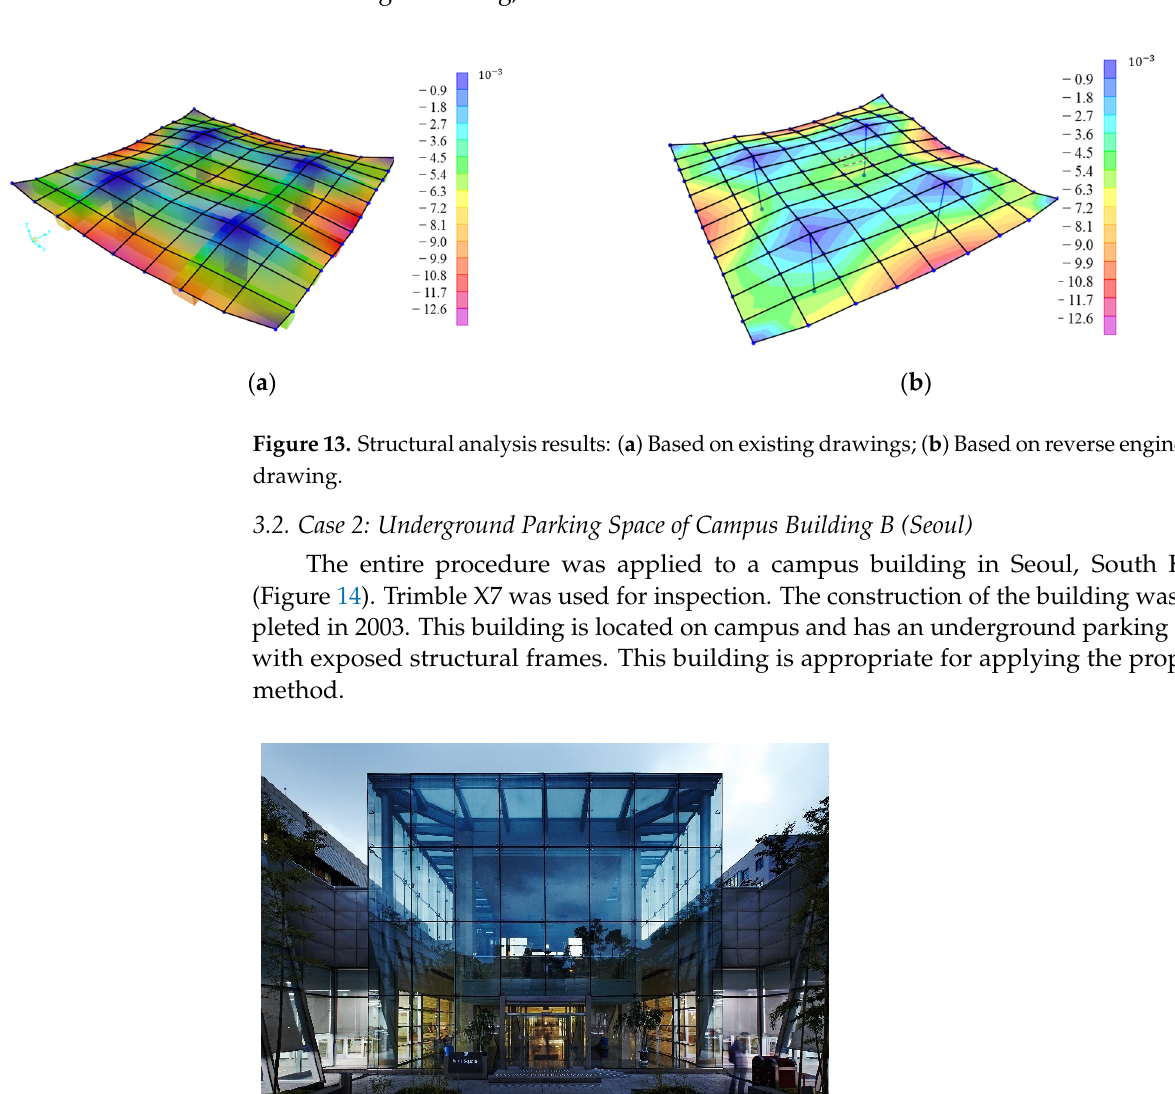
Figure 15. Scanning path of Case 2 (Campus building B). The surveyed PCD processed post-processing information such as registration and noise removal (Figure 16). The scanner measured 282,100,808 points, and the target section points were 66,075,281 points; the remaining points after classifying only structural mem- bers were 45,973,224 points.